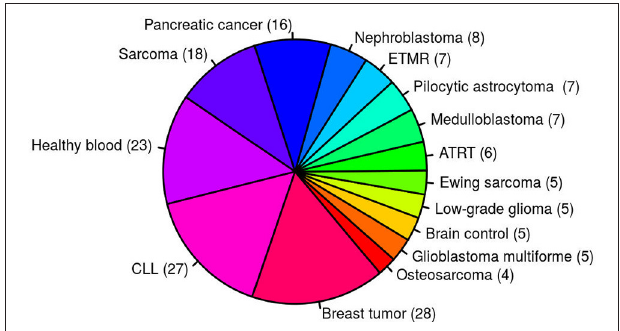
FIGURE 1 | One hundred and seventy-one paired–end RNA–seq samples from 15 different entities were used to generate an artifact list of fusion genes. ETMR, embryonal tumor with multilayered rosettes; CLL, chronic lymphocytic leukemia; ATRT, atypical teratoid rhabdoid tumor.